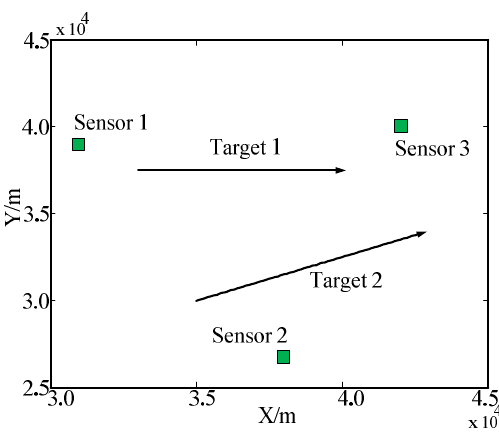
Figure 8. Sensor positions and target trajectories.